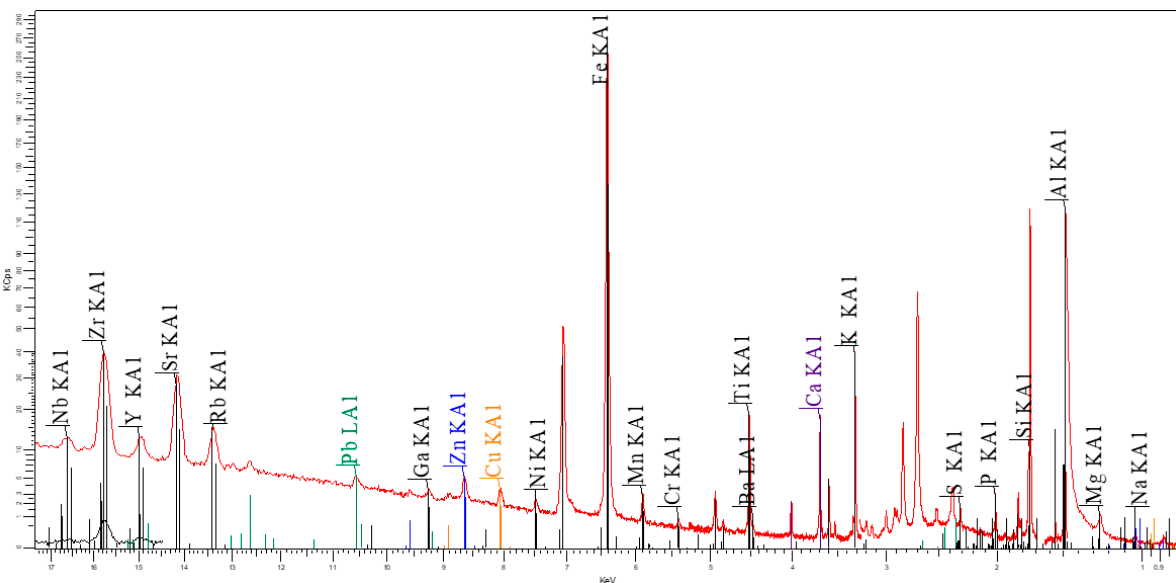
Figure 15. (A) XRF analysis of fly ash pellets before adsorption